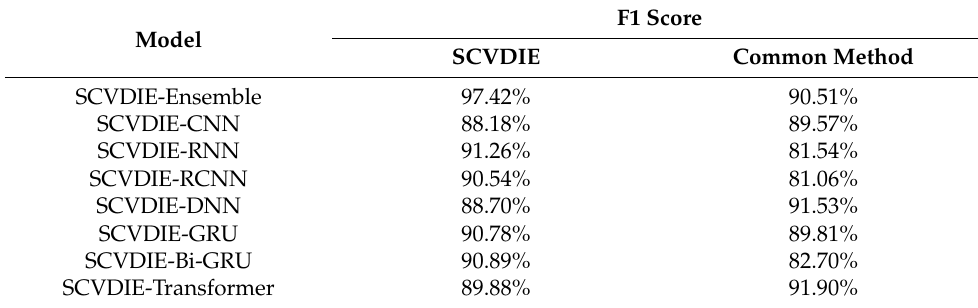
Table 7. Comparison with existing